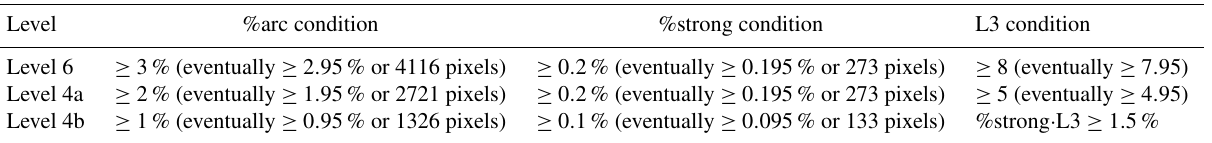
Table 6. Criteria for the activity levels (same format as Tables